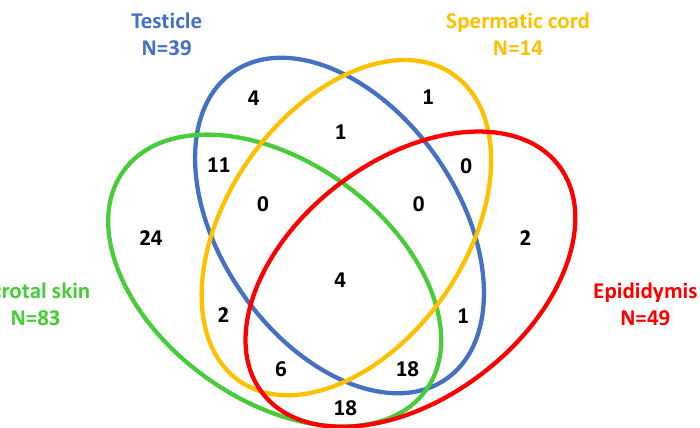
Figure 2. Scrotal skin inflammation, epididymitis, orchitis, and funiculitis in males with Henoch– Schönlein syndrome.